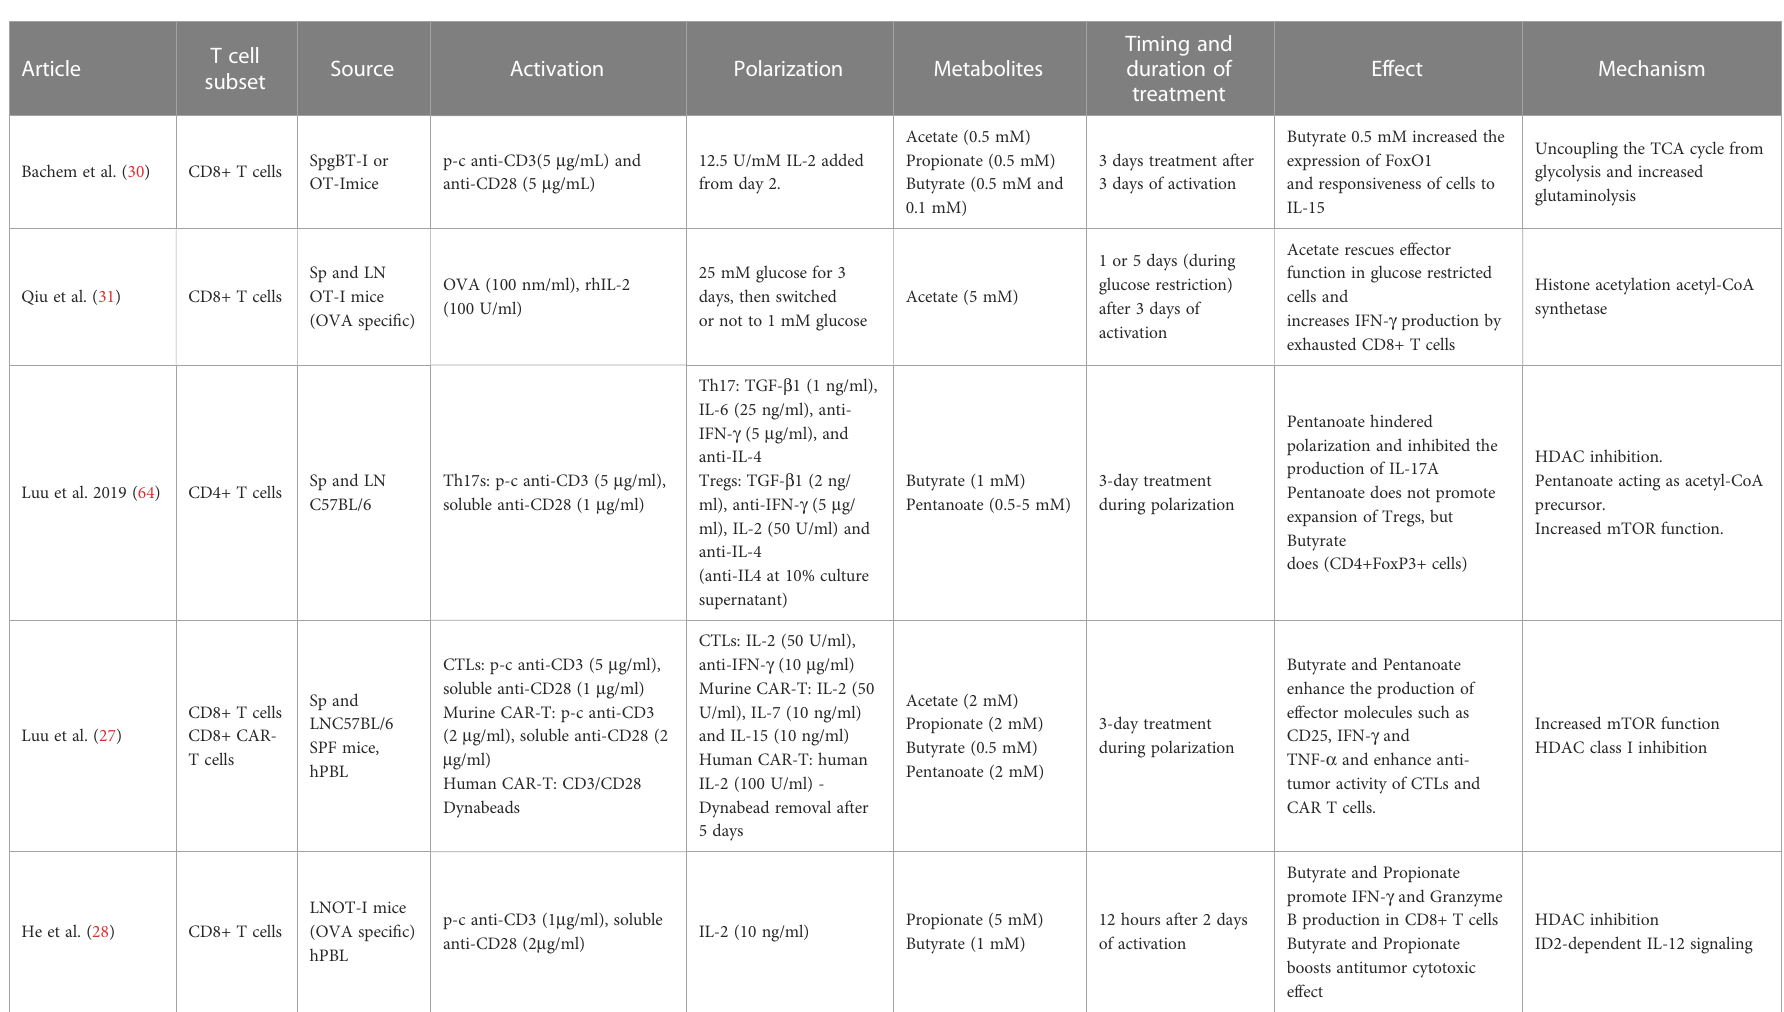
TABLE 3 Summary of methods and results from ex vivo SCFA effects on murine and human T cell